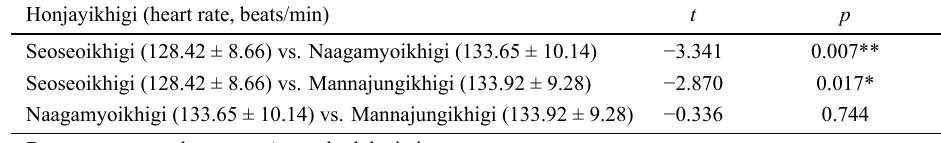
Data are expressed as mean ± standard deviation.